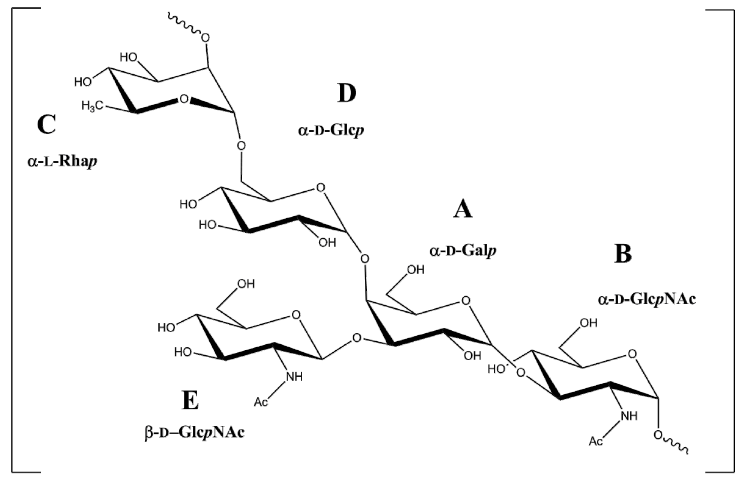
Figure 7. Structure of the O-repeating unit of the O-PS of B. holmesii ATCC 51541.